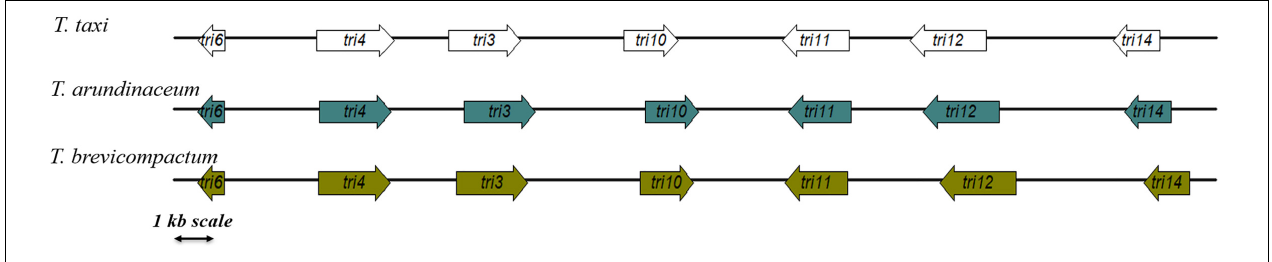
FIGURE 1 | The TRI gene cluster in Trichoderma taxi ZJUF0986, Trichoderma brevicompactum , and Trichoderma arundinaceum . The orientations of arrows represented the direction of transcription, and the relative position of genes was proportionally scaled. TABLE 2 | Comparison of TRI genes from Trichoderma taxi with orthologues from Trichoderma arundinaceum , Trichoderma brevicompactum , and Fusarium sporotrichioides . T. taxi TRI